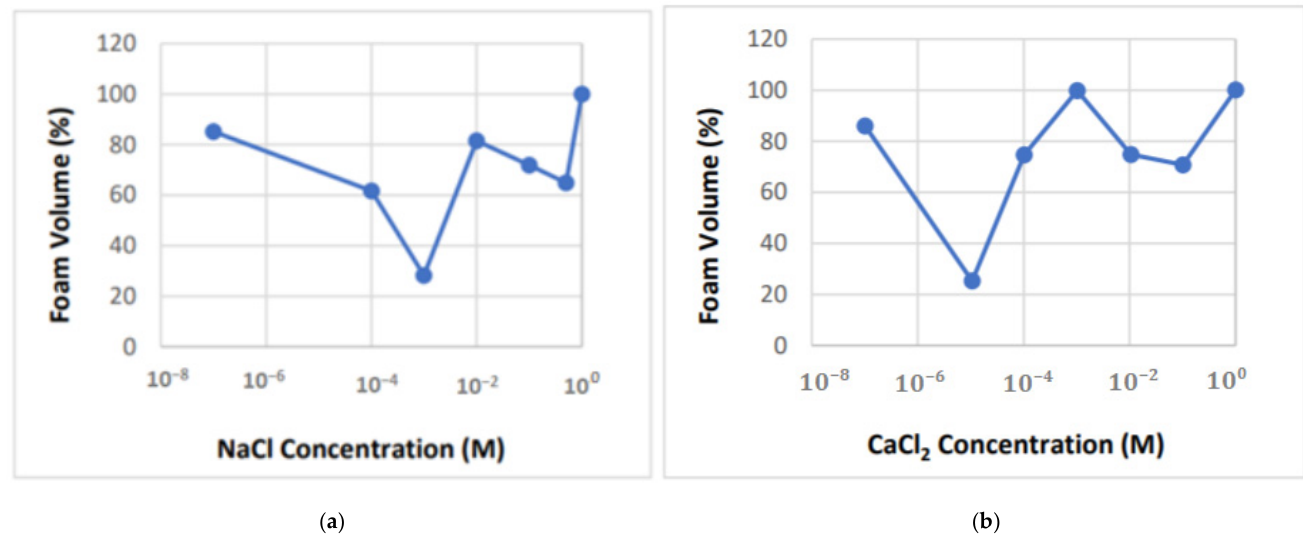
Figure 1. Foamability of 0.005 Wt% surfactant solution vs. salinity: ( a ) NaCl and ( b ) CaCl 2 (data from Liu et al., 2005).